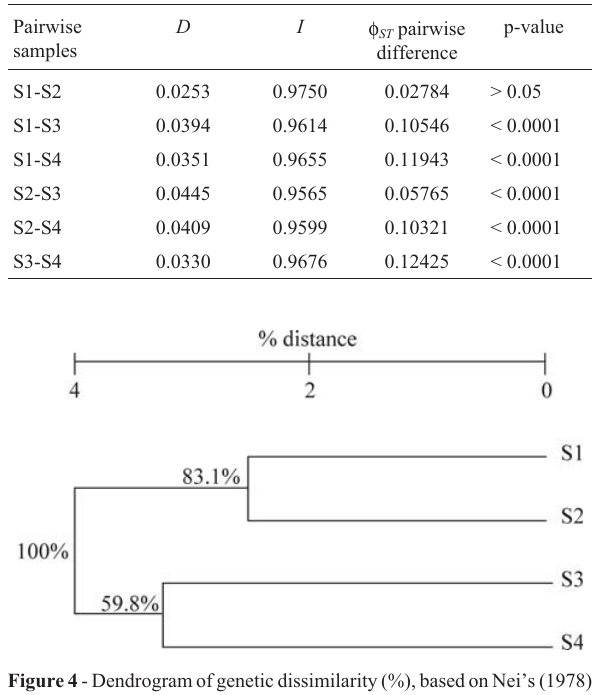
Table 4 - Estimation of Nei’s (1978) unbiased genetic distance ( D ) and identity ( I ), with Lynch and Milligan (1994) correction, between pairs of H. ancistroides from four different sites (S1, S2, S3 and S4) on the Cambé stream. AMOVA ( φ ST ) pairwise differences and p-value are also shown.